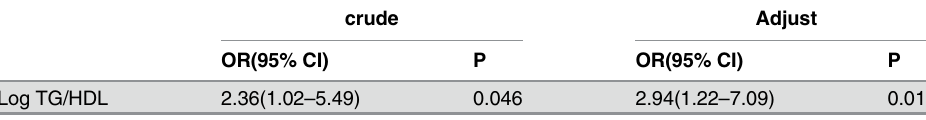
Adjusted for age, gender, hypertension, smoking, diabetes by using the logistic regression